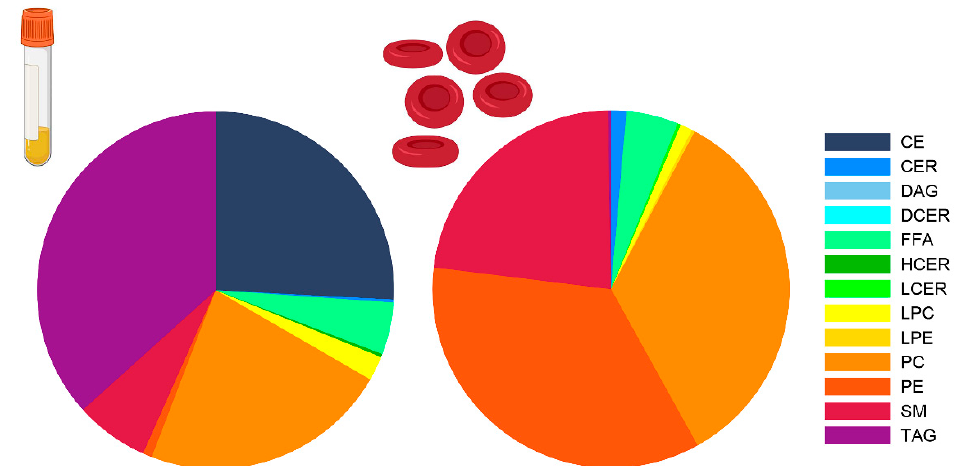
Figure 2. Plasma and erythrocyte lipid class composition. Lipid class composition in plasma (left) and erythrocytes (right) as a percentage of the total lipid concentration. Abbreviations: CE = cholesteryl ester, CER = ceramide, DG = diacylglycerol, DCER = dihydroceramide, FFA = free fatty acid, HCER = hexosylceramide, LCER = lactosylceramide, (L)PC = (lyso)phosphatidylcholines, (L)PE = (lyso)phosphatidylethanolamine, SM = sphingomyelin, TAG = triacylglycerol.